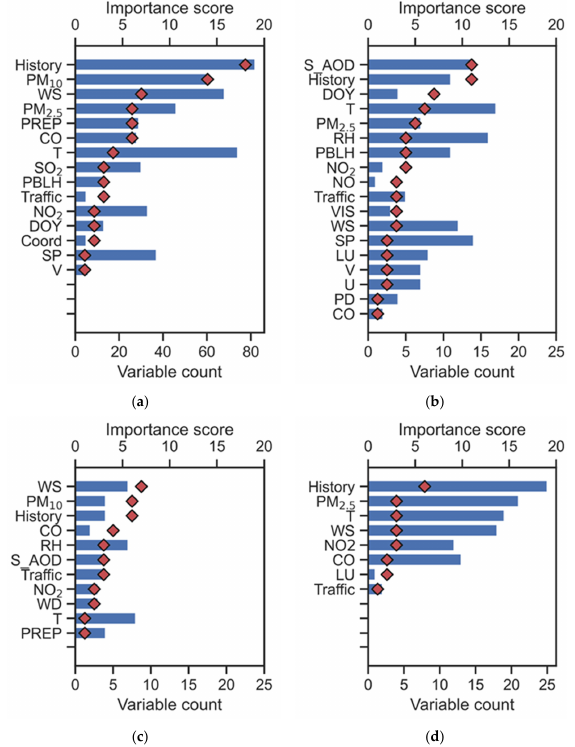
Figure 4. Variable importance in PM pollutants: ( a ) TCOB models; ( b ) tree models; ( c ) LR; ( d ) modern DL structure models. Blue bars present the variable count, and red diamonds present the importance score.